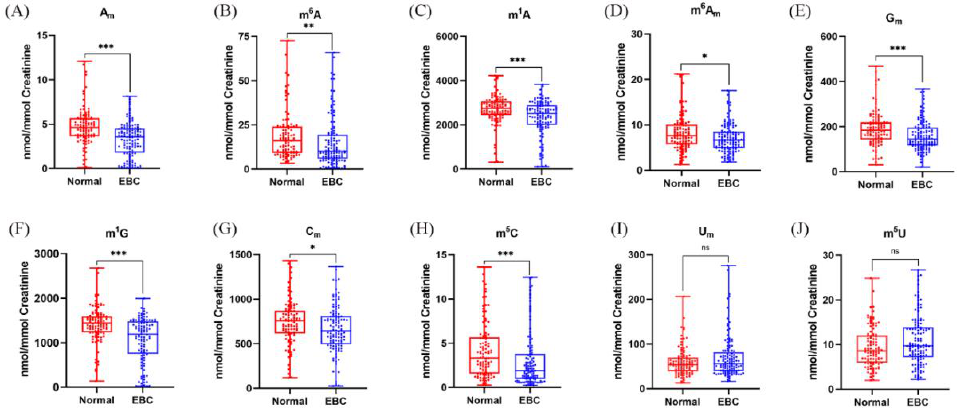
Figure 4. The calibrated concentrations of ( A ) A m , ( B ) m 6 A, ( C ) m 1 A, ( D ) m 6 A m , ( E ) G m , ( F ) m 1 G, ( G ) C m , ( H ) m 5 C, ( I ) U m , and ( J ) m 5 U in the urine samples of normal controls and EBC patients. (ns p > 0.05, * p < 0.05, ** p < 0.001, *** p < 0.0001).